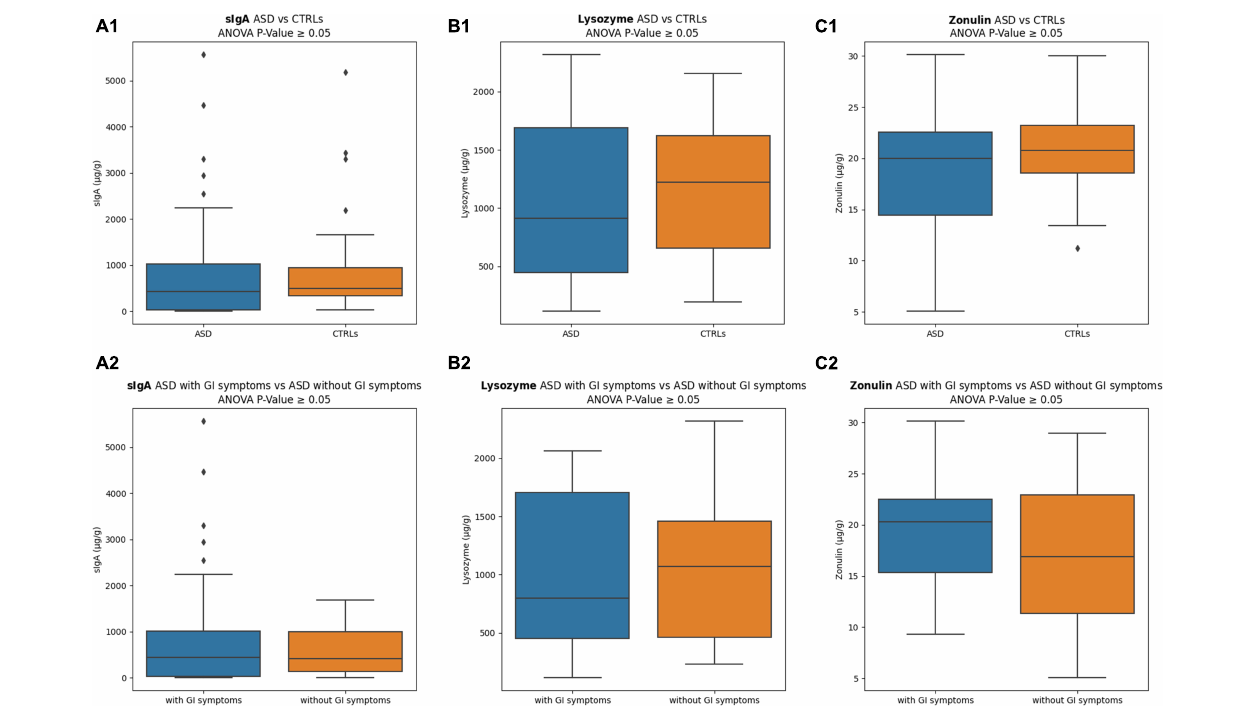
FIGURE 2 | Inflammation and intestinal permeability markers. (A1) sIgA comparison between ASD versus CTRLs; (A2) sIgA comparison between ASD with GI symptoms versus ASD without GI symptoms; (B1) lysozyme comparison between ASD versus CTRLs; (B2) lysozyme comparison between ASD with GI symptoms versus ASD without GI symptoms; (C1) zonulin comparison between ASD versus CTRLs; (C2) zonulin comparison between ASD with GI symptoms versus ASD without GI symptoms. The interquartile range is represented by the box, and the line in the box is the median. The whiskers highest and lowest data points are reported, while the dots represent the